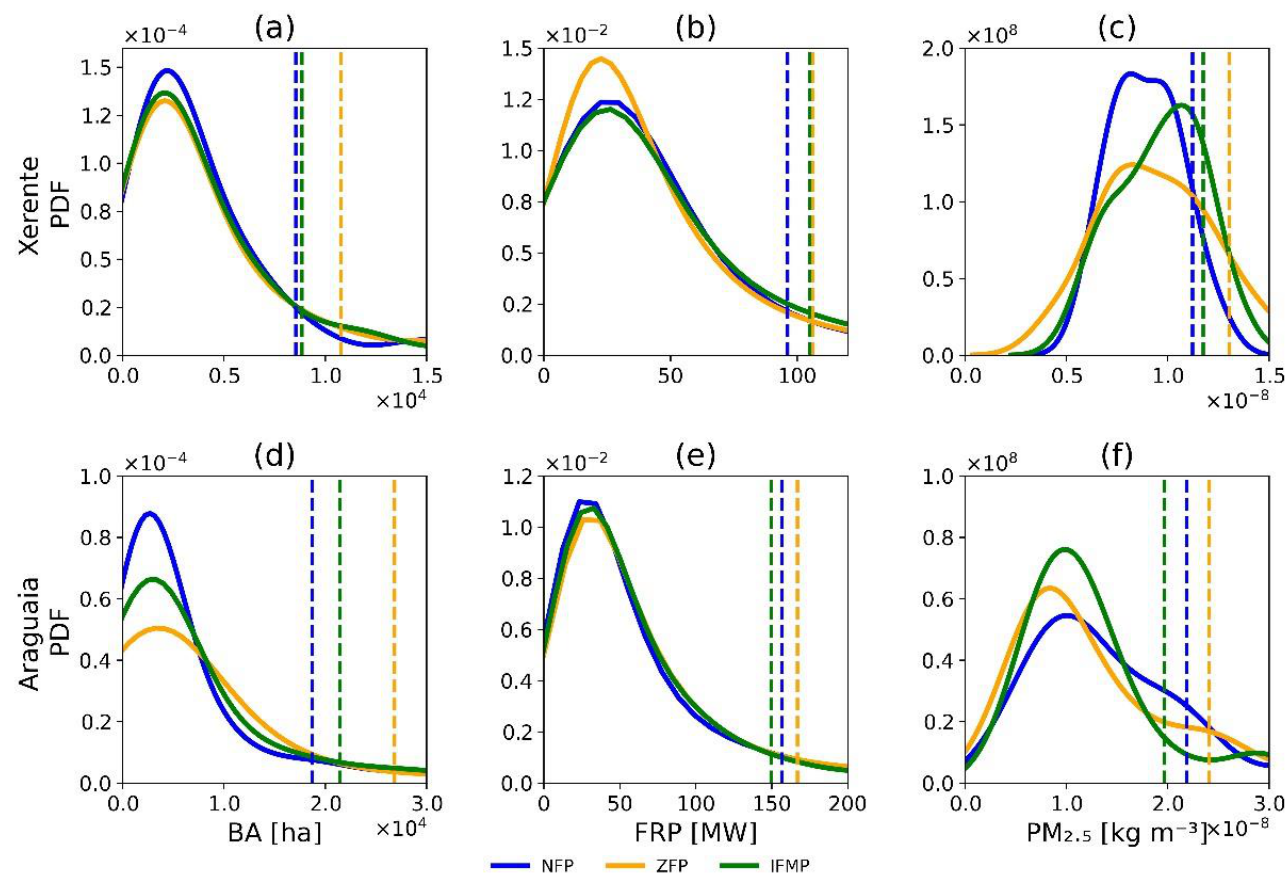
Figure 4. Kernel Probability density function (PDF) of burned area (BA, ha) for large scars ( a , d ), Fire Radiative Power (FRP, MW, b , e ) and pyrogenic emission (PM 2.5 , kg · m − 3 , c , f ) for WFS during each phase (NFP—blue, ZFP—yellow, IFMP—green) for in the Xerente ( upper row ) and Araguaia ( bottom row ). The dashed lines represent the 90th percentile for each respective phase.